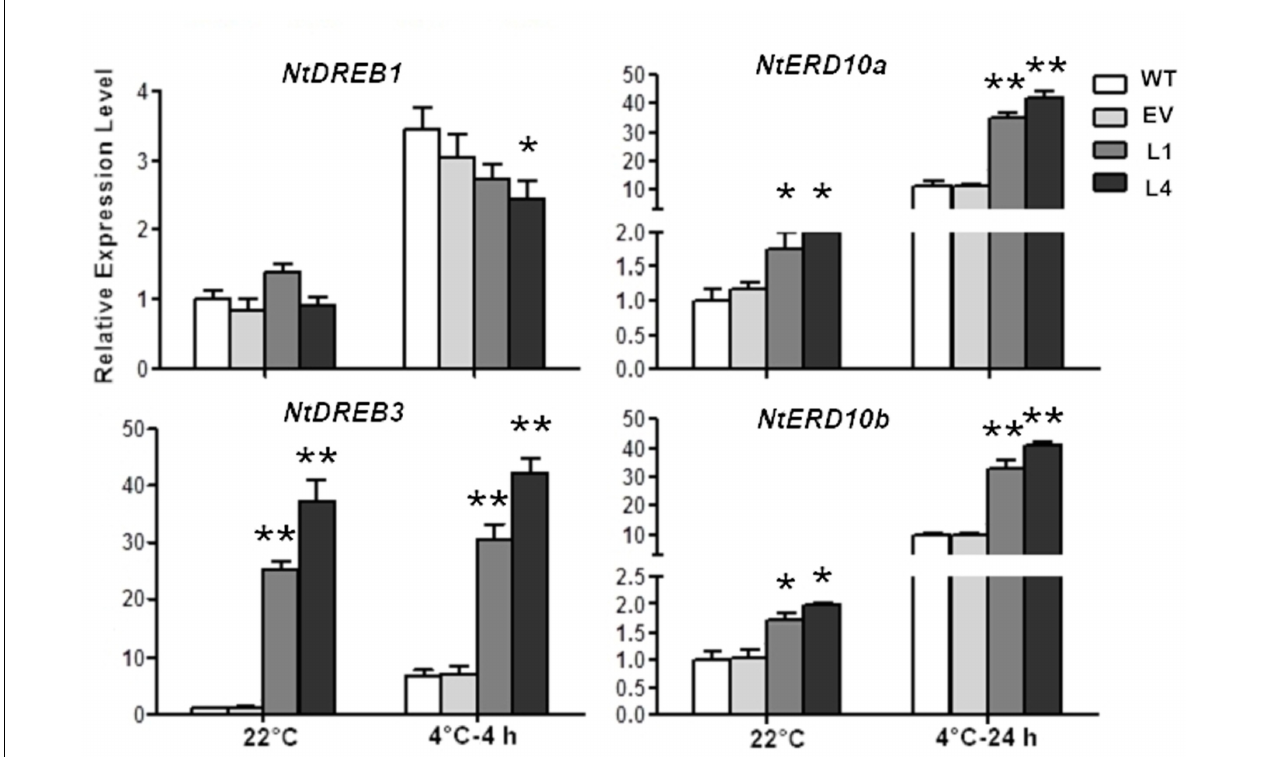
FIGURE 6 | CbRCI35 activated cold responsive genes in tobacco plants. The relative expression of NtDREB1 , NtDREB3 , NtERD10a, and NtERD10b in CbRCI35-ox tobacco plants before and after cold treatments. The NtActin gene was performed as an internal control. Data are means ± SD ( n = 3, ∗ P < 0.05, ∗∗ P <